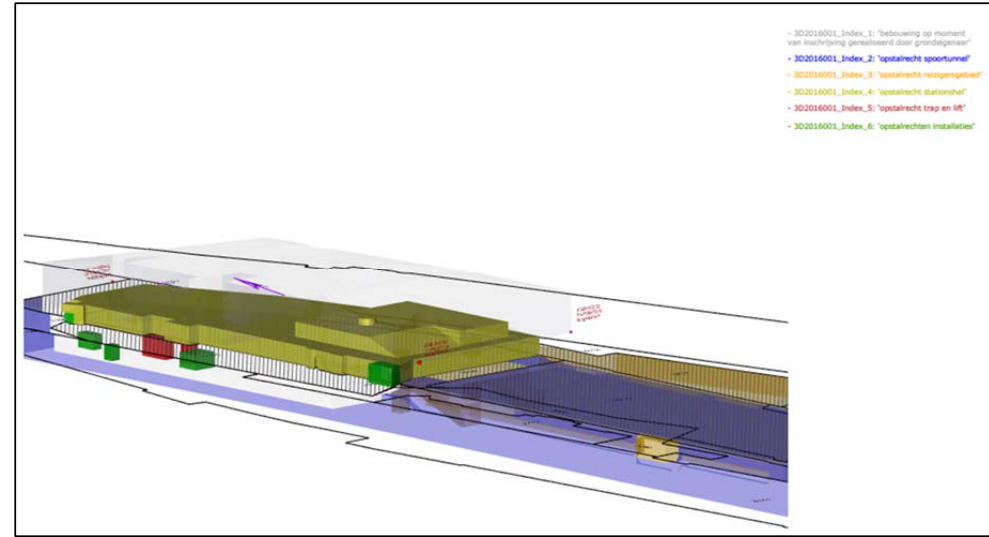
Figure 4. 3D PDF, official document that visualises the multi-level property rights in 3D (case Delft station).